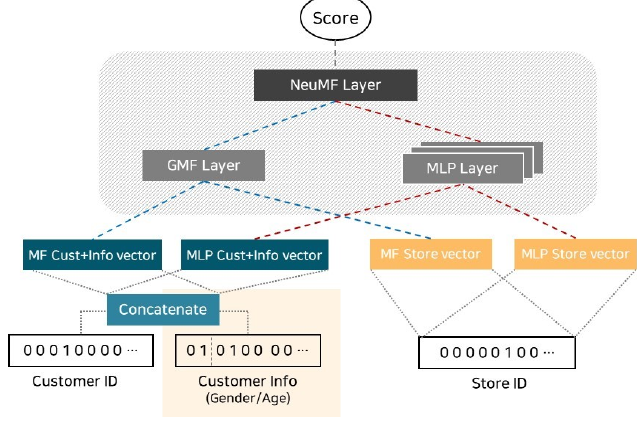
Figure 4. Structure of NMF with Customer Information (NMF_CI).